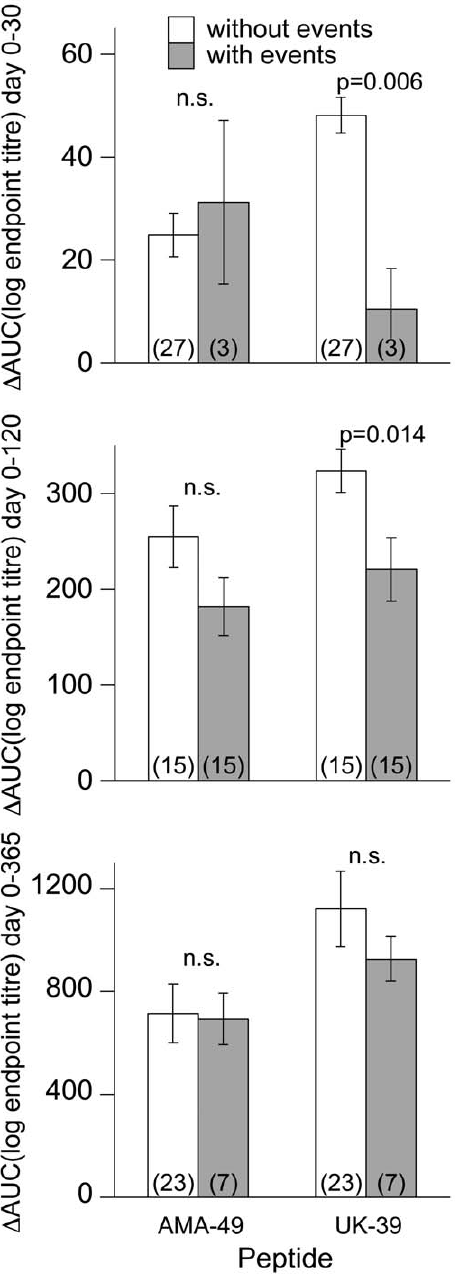
Figure 5. Comparison of the integrated antibody responses against AMA49-C1 and UK-39 with the detection of malaria parasitaemia in PEV3B children during time periods Day 0–30, Day 0–120 and Day 0–365. D AUC was calculated as the area under the log (antibody titer)-curve above the baseline antibody titer. D AUC values were compared between those PEV3B children who did not have positive smears for P. falciparum and those PEV3B children who were tested positive for parasites using Wilcoxon’s test. The numbers (in brackets) in the bars indicate the number of PEV3B in each of the groups